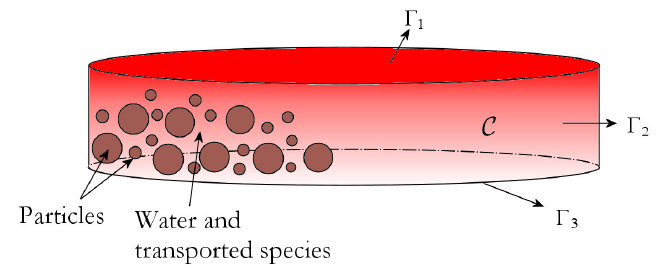
Figure 1. Domain of the percolation